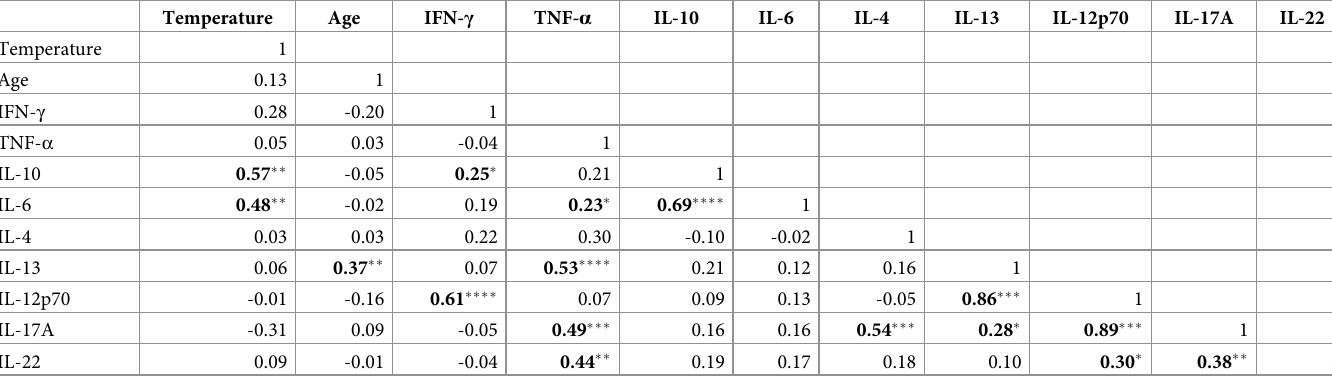
Table 3. Multivariate bilateral analysis between cytokines, age and temperature in symptomatic children.